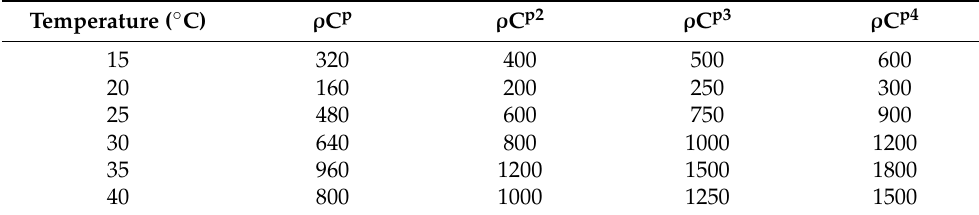
Table 9. Variation of the nanofluid’s specific heat (J/K/mol) with temperature and the volume of